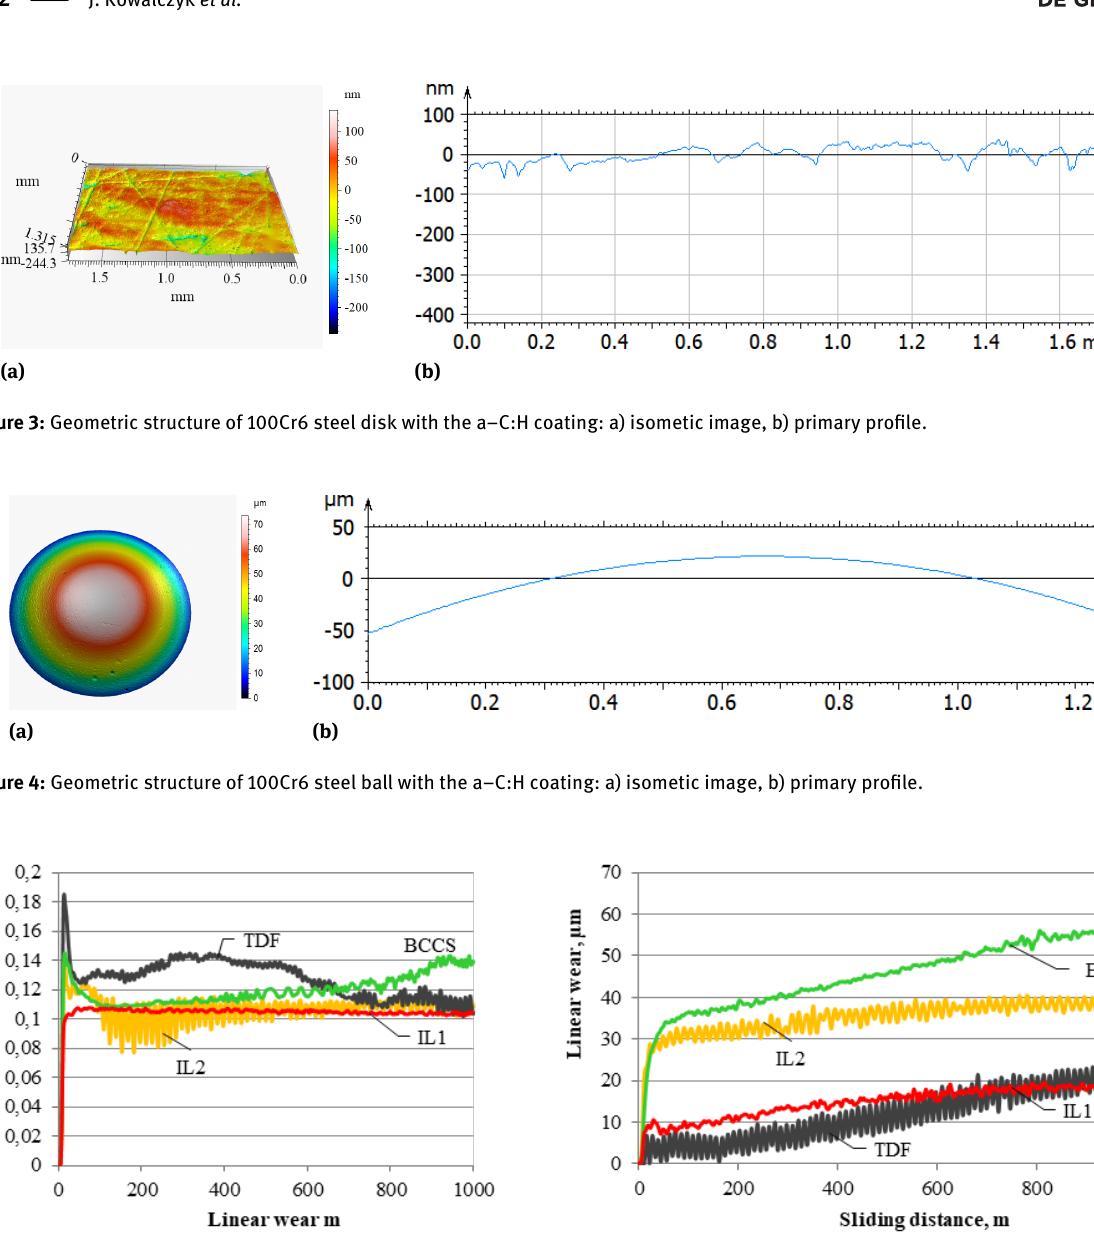
Figure 5 shows the results of the tribological tests: mean coefficient of friction (Figure 5a) and intensity of lin- ear wear (Figure